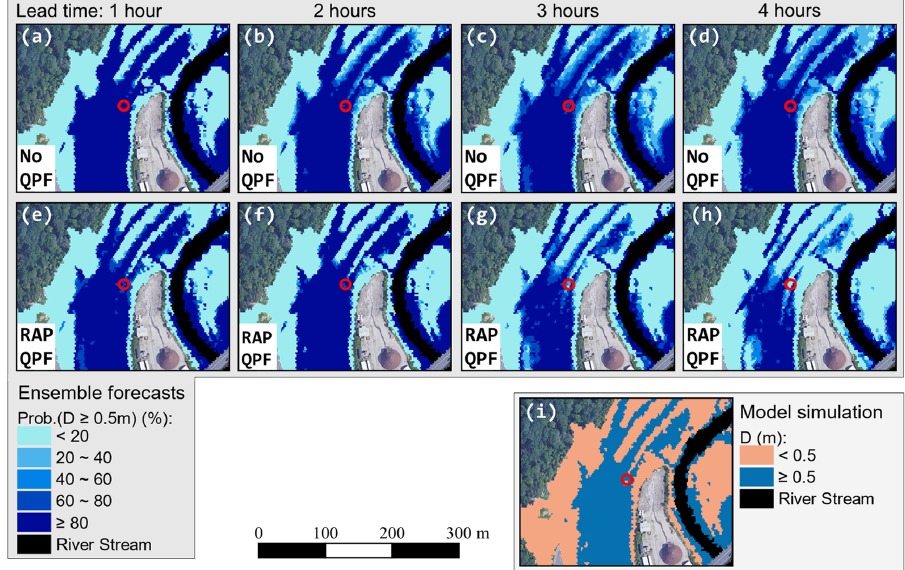
Figure 16. Inundation maps forecasted by the surrogate models without QPF ( a – d ), with QPF ( e – h ), and simulated by the hydrodynamic model ( i ) at the peak water level of the 2 August 2020, event at POI 1 (red circle in the maps).